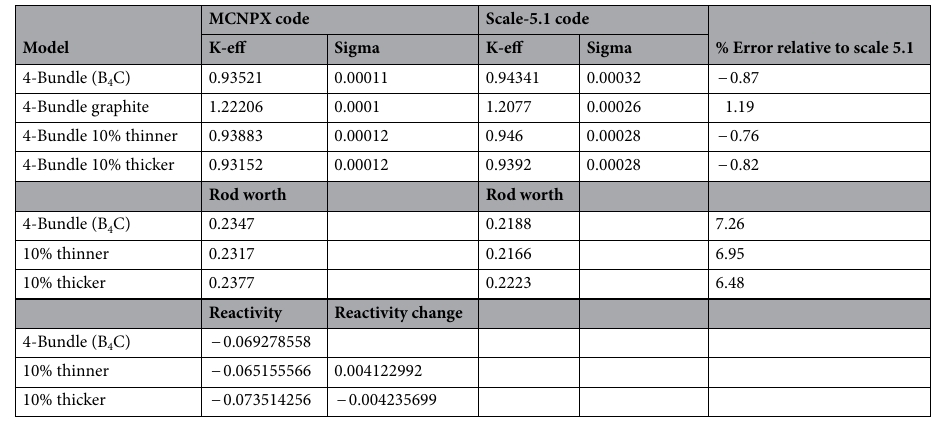
Table 2. K-eff for different models of F-lattice calculated by MCNPX and KENO